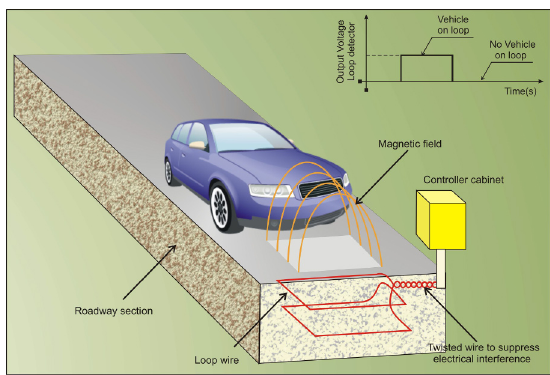
Figure 1. Inductive loop detector principle